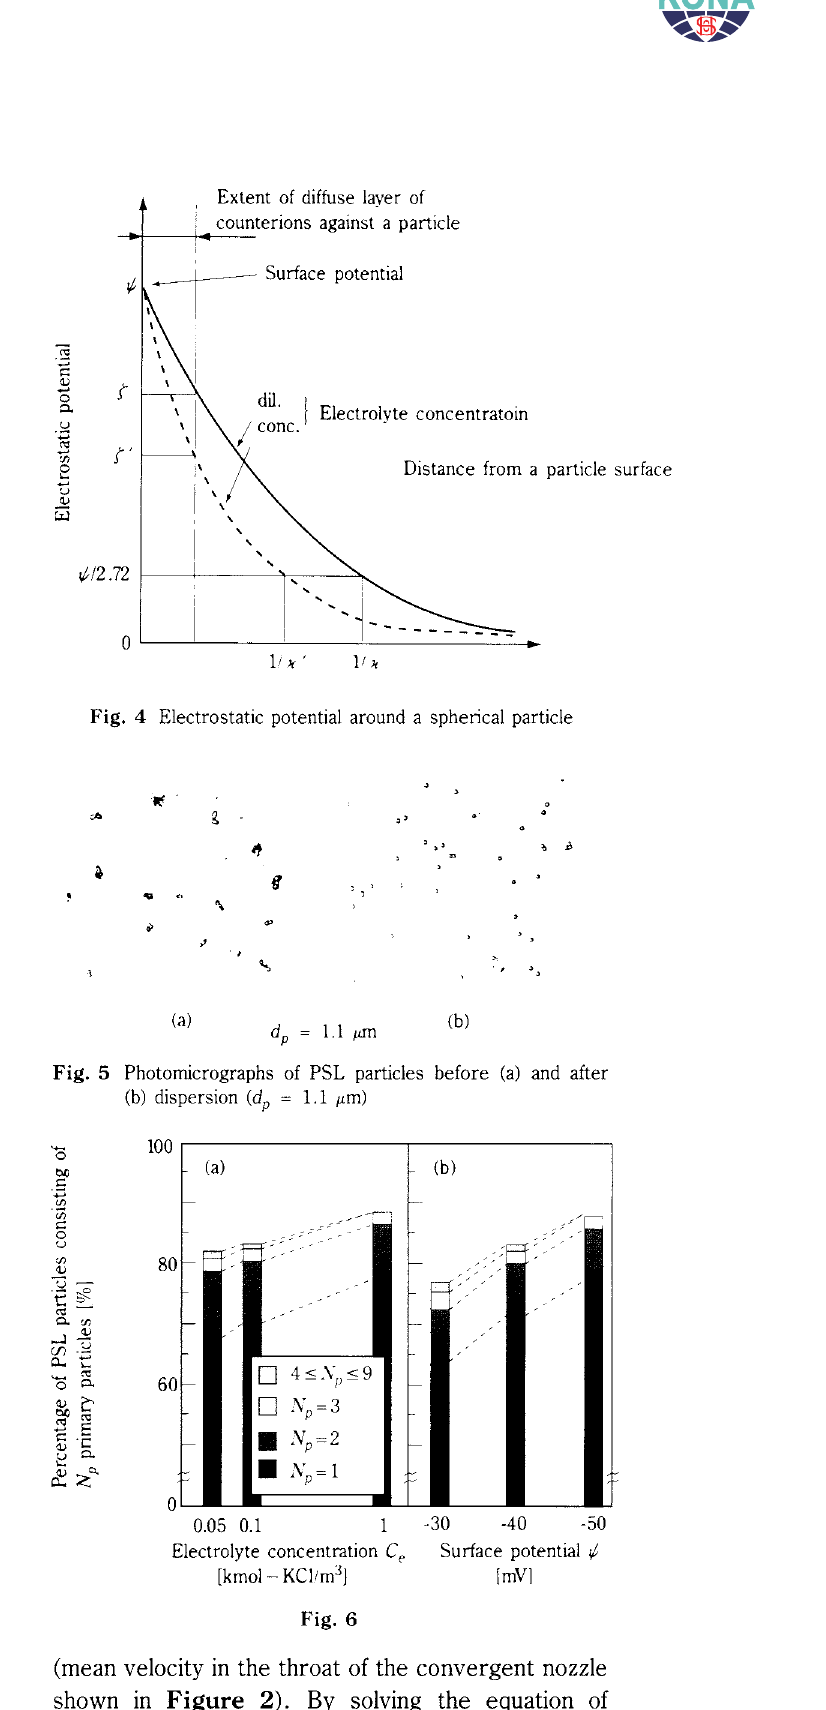
(mean velocity in the throat of the convergent nozzle shown in Figure 2). By solving the equation of motion for particles in the convergent nozzle, Ur (relative velocity of particle and fluid) is obtained in an arbitrary agglomerated state3l. From this Un Fig. 3 j potential of PSL particles